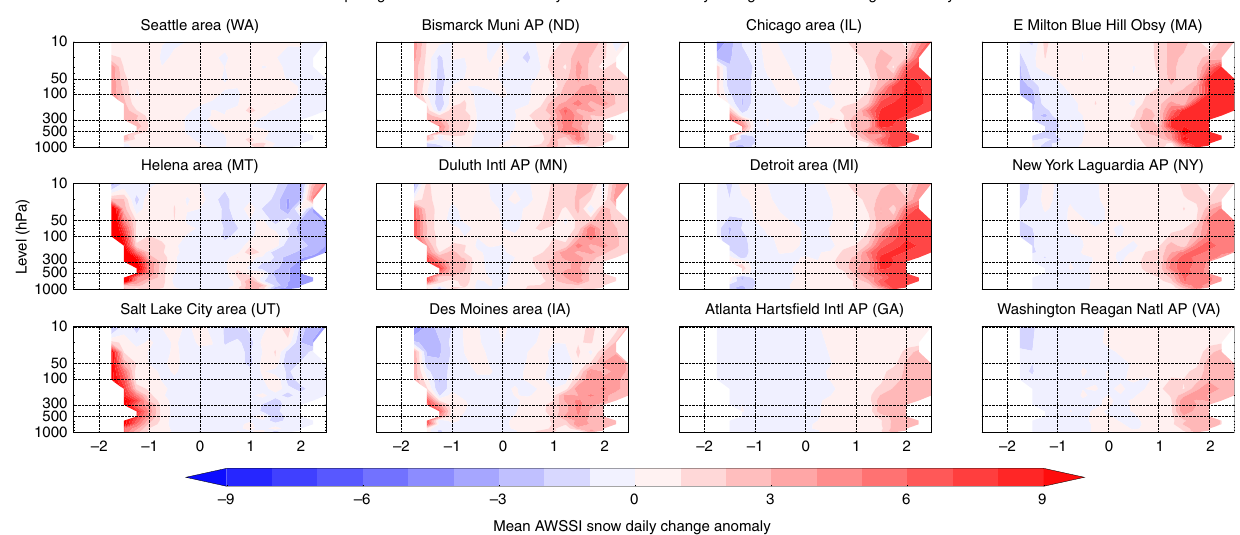
Fig. 6 Polar cap variability leads increased severe weather up to 19 days. The average daily change in the AWSSI at selected weather stations across the US associated with polar cap geopotential height anomalies (PCH) from the surface to the mid-stratosphere (10 hPa) during 5 – 19 days preceding the